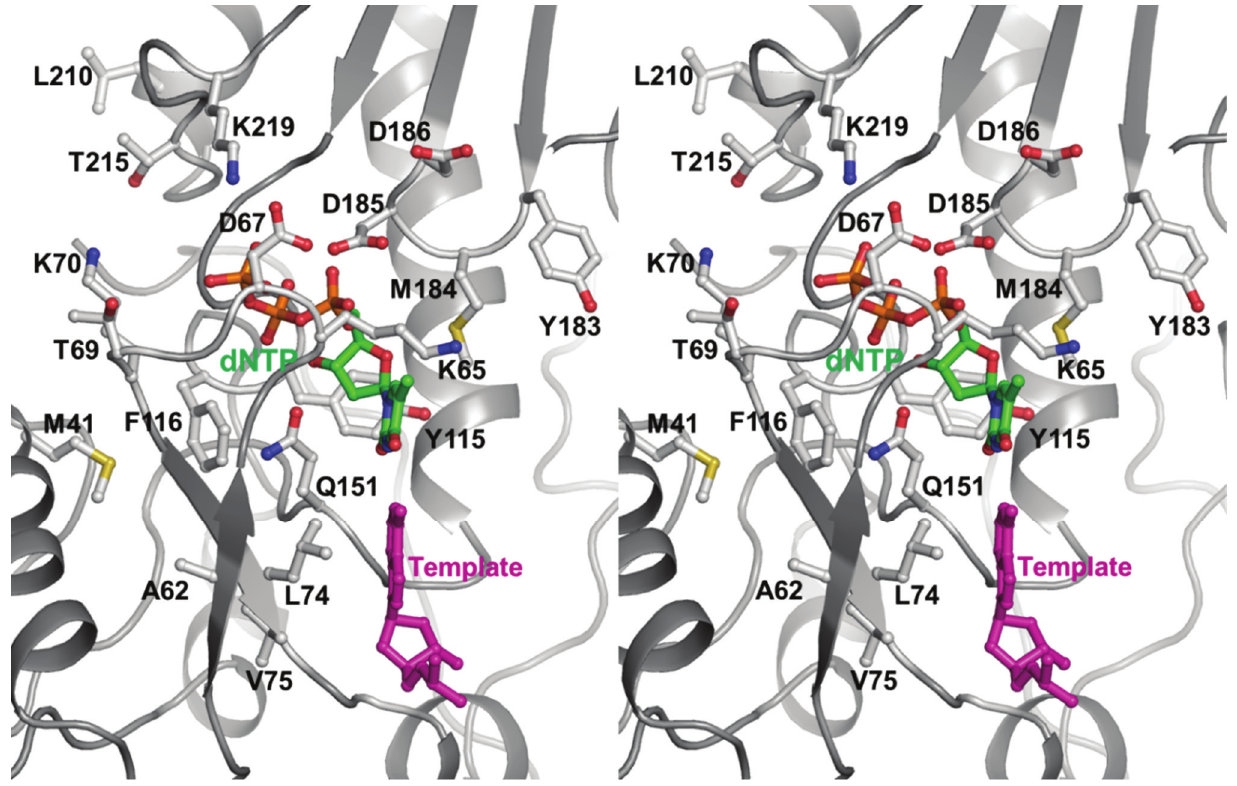
Figure 3. FDA-approved NNRTIs: nevirapine (NVP), efavirenz (EFV), delavirdine (DLV), etravirine (ETV), and rilpivirine (RPV). Currently, DLV is not recommended by the US Department of Health and Human Services. ETV, RPV, and sometimes EFV, are referred to as second-generation NNRTIs.